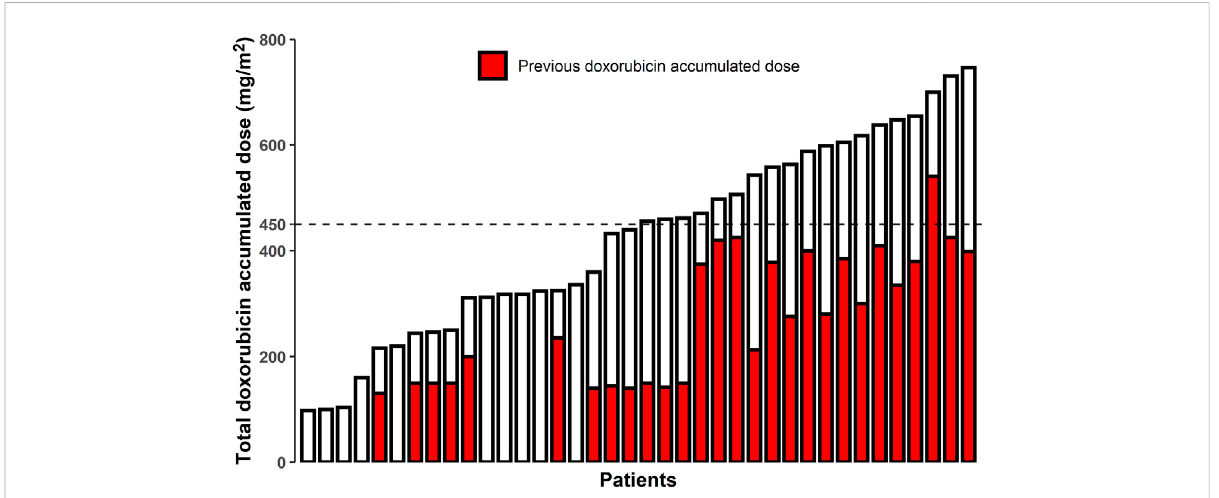
FIGURE 2 Cumulative doxorubicin dose for patients in this study. Ten patients had not received doxorubicin (or anthracyclines) before the study. The highest total doxorubicin cumulative dose was 747 mg/m 2 . The total doxorubicin cumulative dose exceeded the traditionally recommended upper limit of 450 mg/m 2 in 19 patients.